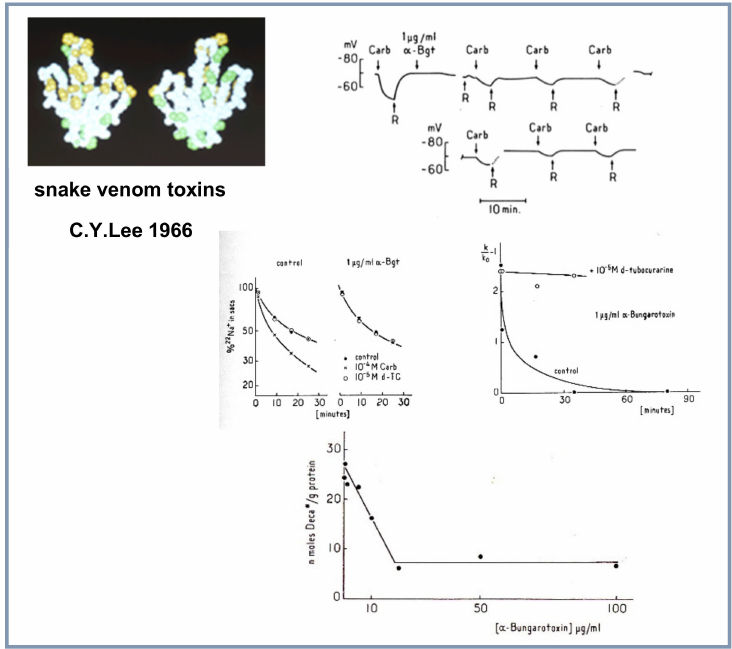
Figure6. Theuseof thesnakevenomtoxin α -bungarotoxintoidentifythenAChRfromtheelectroplaque (top), the excitable microsacs (middle) and the detergent solubilized extract (bottom) (Reproduced from